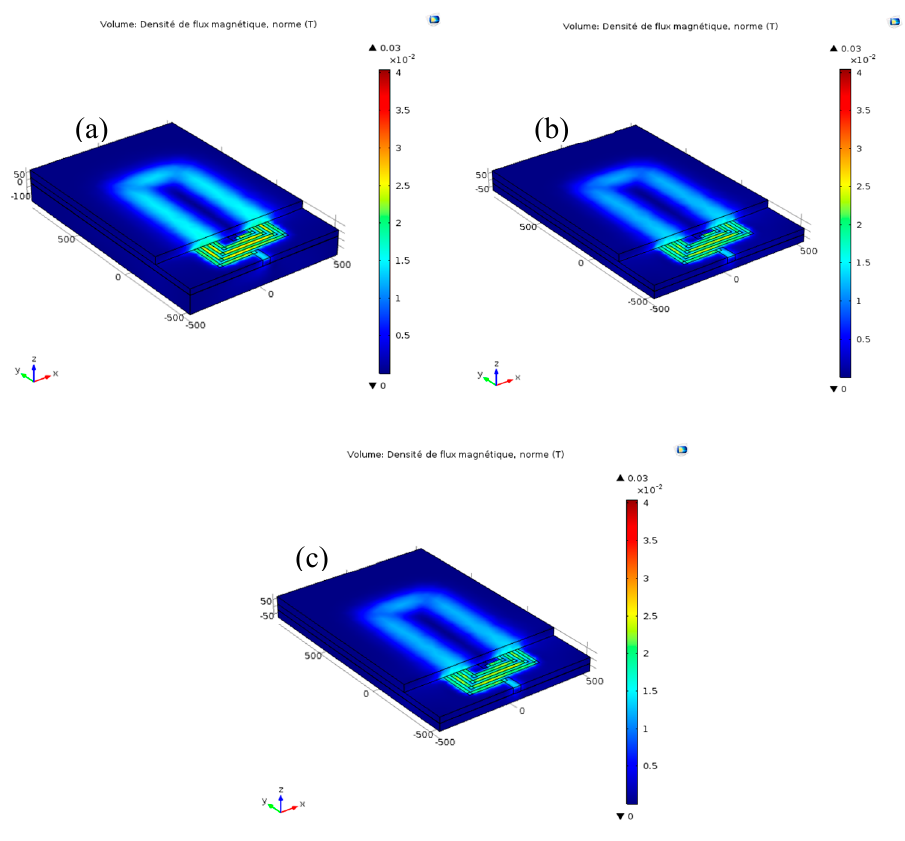
Figure 2. Distribution of the magnetic field density for an excitation of 1 A. ( a ) on a kapton substrate; ( b ) on a PEEK substrate and ( c ); on a PEN substrate.